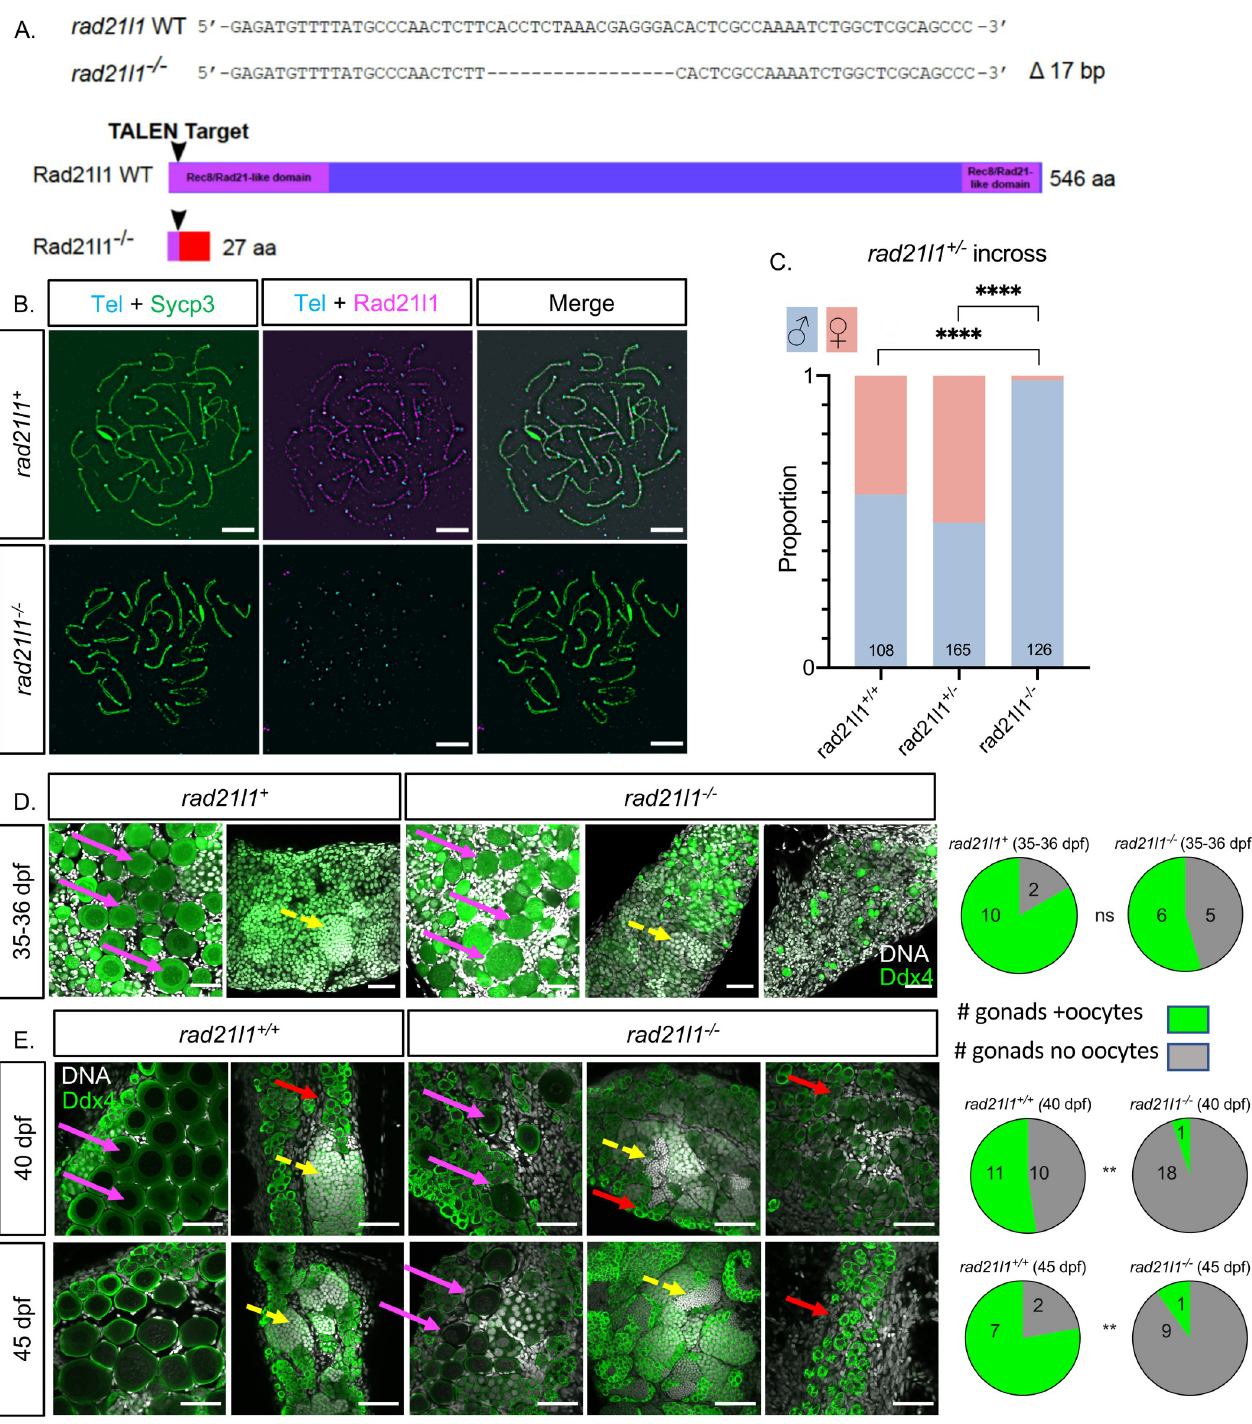
Fig 2. rad21l1 -/- mutants are predominantly male due to late sex reversal. (A) TALEN generated 17-bp deletion leads to a frameshift mutation resulting in a truncated 27 amino acid (aa) Rad21l1 protein with the conserved Rec8/Rad21-like family domains (1–100 aa and 495–543 aa) disrupted or deleted. Rec8/ Rad21-like domains (purple boxes); altered amino acid sequence (red box). The ATG translational start site is located at the 4th-6th nucleotide from the end. (B) Spermatocyte nuclear spreads stained for telomeres (cyan), Sycp3 (green), and Rad21l1 (magenta). Rad21l1 forms lines of foci along the Sycp3 axis in rad21l1 +/- spermatocytes. In the rad21l1 mutant, no lines of Rad21l1 foci are seen. The rad21l1 mutant spermatocytes can form axes and pair homologs albeit with some asynapsed regions. Scale bar = 5 μ m. (C) Sexed offspring of a rad21l1 +/- incross show a depletion of females in rad21l1 - /- fish. Data pooled from multiple crosses. (D) Sections of gonads prepared from 35–36 dpf r ad21l1 +/+ and rad21l1 +/- (labelled rad21l1 + ) and rad21l1 -/- fish and stained for DNA (gray)